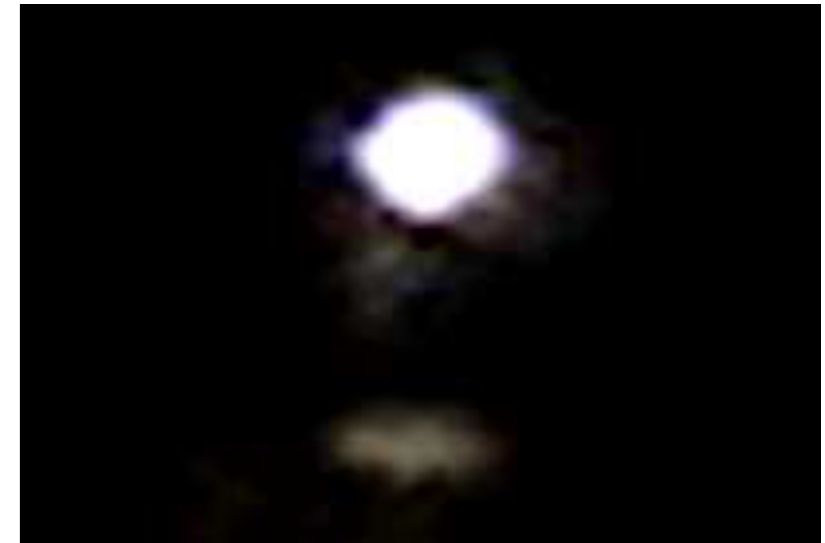
Fig. 2. A luminous sphere observed at 01:53LT on 22 February 2009, near Preturo. Courtesy of Giuseppe Marrone. Fig.2. Aluminoussphereobservedat01:53LTonFebruary22,2009,nearPreturo. CourtesyofGiuseppeMarrone. 6 gioni,Aragno,Gignano,Tempera,Paganica,Camarda,Colle Roio, Santa Ruffina, Roio Poggio, Pianola, Bagno, Vallesin- dolaofBagno,Fossa,SanDemetrio,MonticchioandPoggio Picenze. Fourteen cases of electrical discharges were reported around and at the time of the main shock. They were observed without thunderstorms, with thin clouds through which it was possible to see the light of the stars or with- out clouds. Such discharges were less luminous than light- ning bolts, as they did no illuminate the landscape in the neighborhoods, and they were either white, green or a shade ranging from red to violet. Ms. Fiorella De Meo, from the West Aquila highway, remembers that at the tail end of the main shock and also after it, she saw about ten thin green- ish blue electrical discharges to north just above Arischia and Cansatessa. Each event was very brief, while together they lasted for about ten seconds. Some of the electrical dis- charges appeared simultaneously crossing each other. Ms. Pettino, Pile, Roio Poggio, Colle Roio, Paganica and above